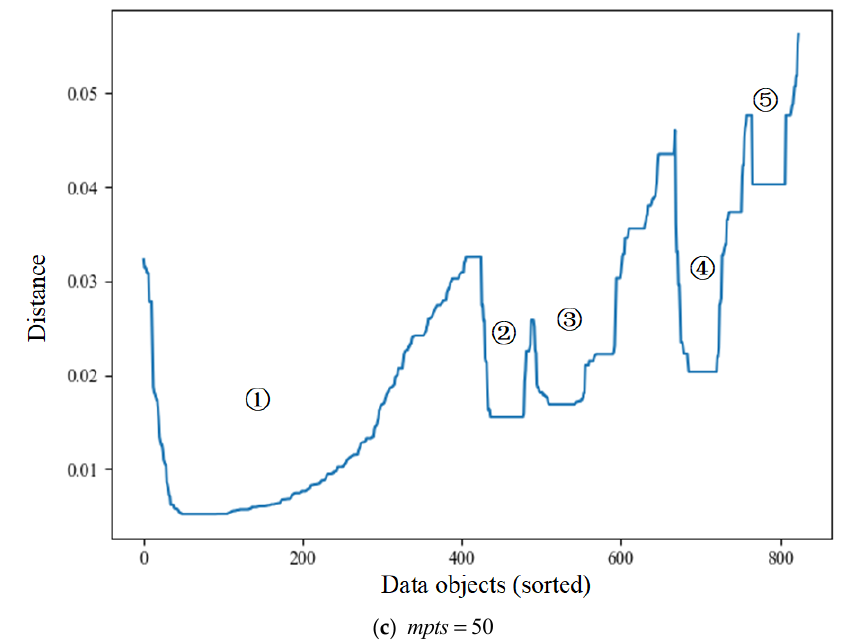
Figure 6. Reachability-like plots based on “PDIA-SL” dataset.